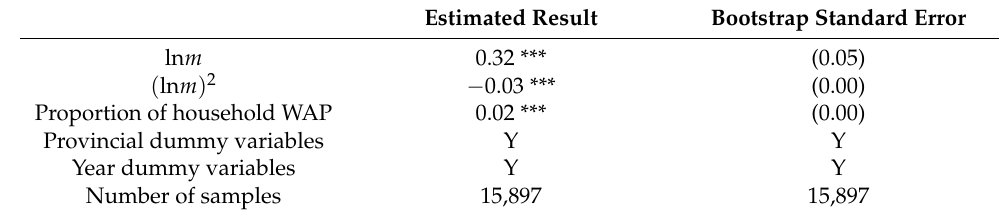
Table A2. Estimation results from the Working–Leser